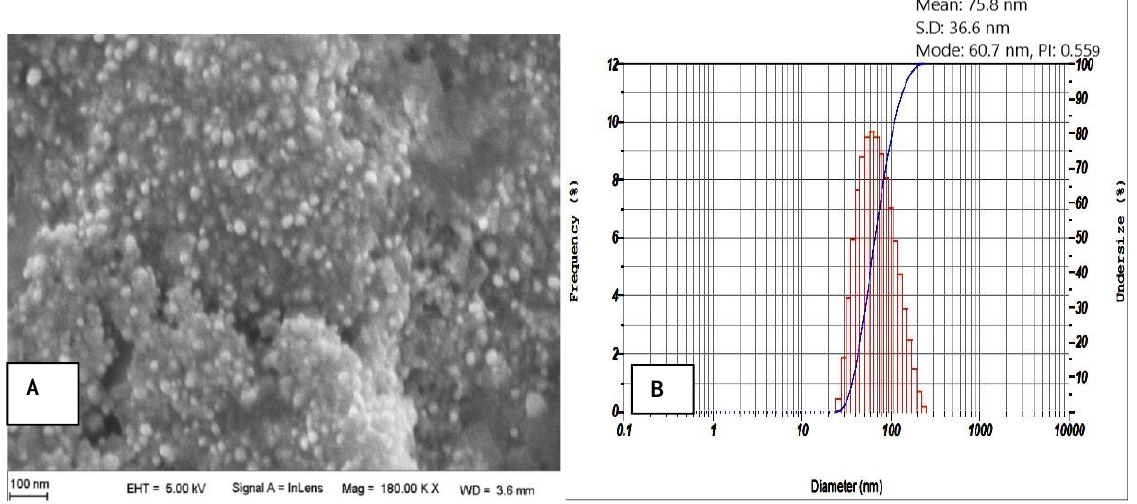
Figure 5. ( A ). SEM micrographs of TPE-mediated ZnO NPs. viewed at 180 K × magnifications with a 100 nm scale, ( B ). PSD of TPE-mediated ZnO NPs. The data indicate NPs < 100 nm and a PI < 0.7 demonstrating relatively small NPs and uniform PSD.